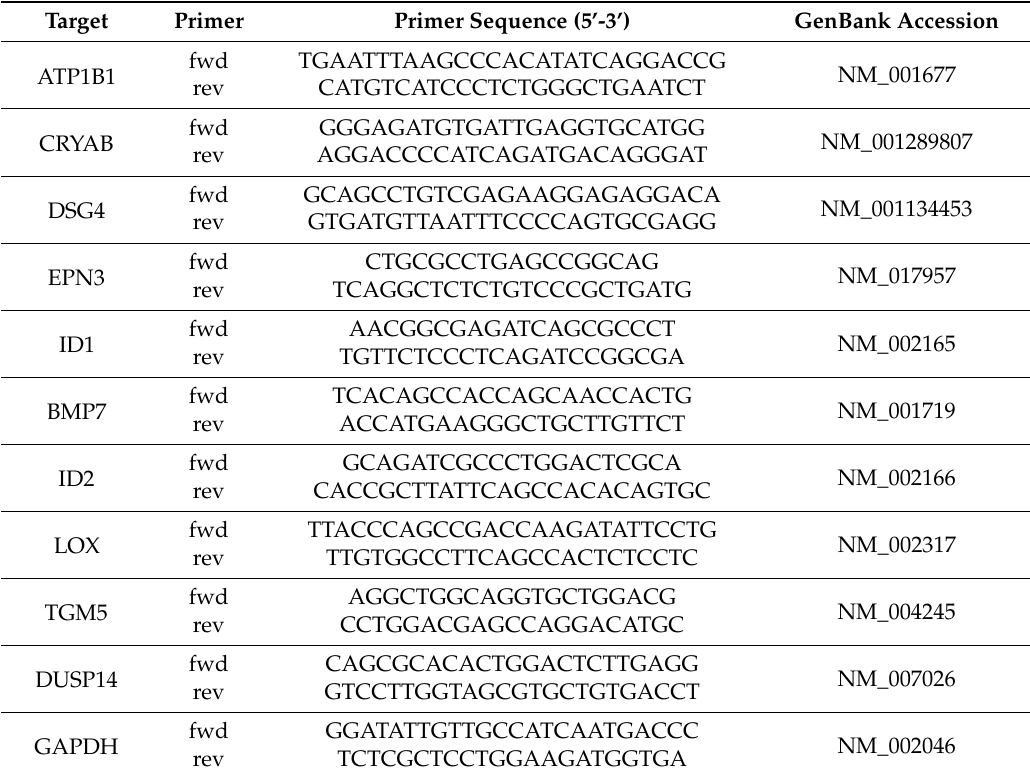
Table 4. List of primers used in the present